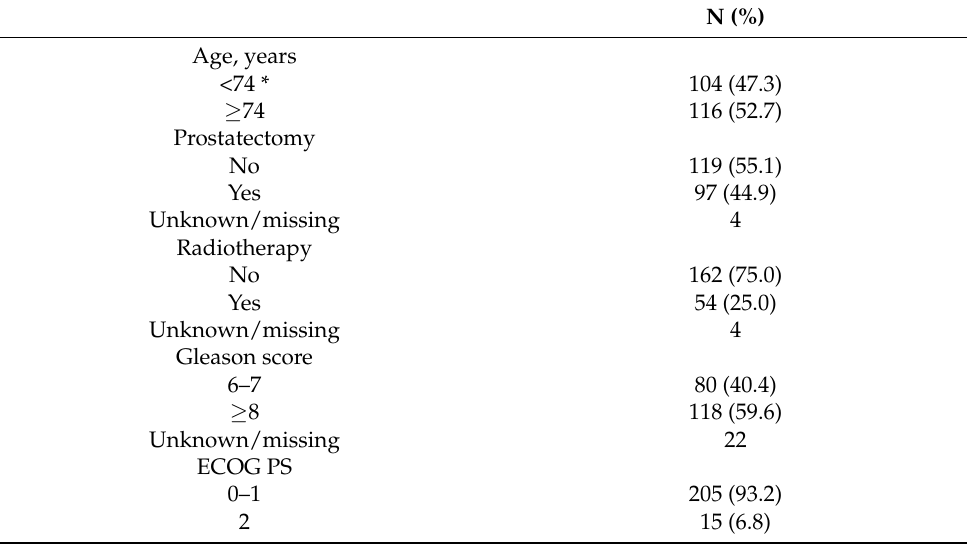
Table 1. Patient